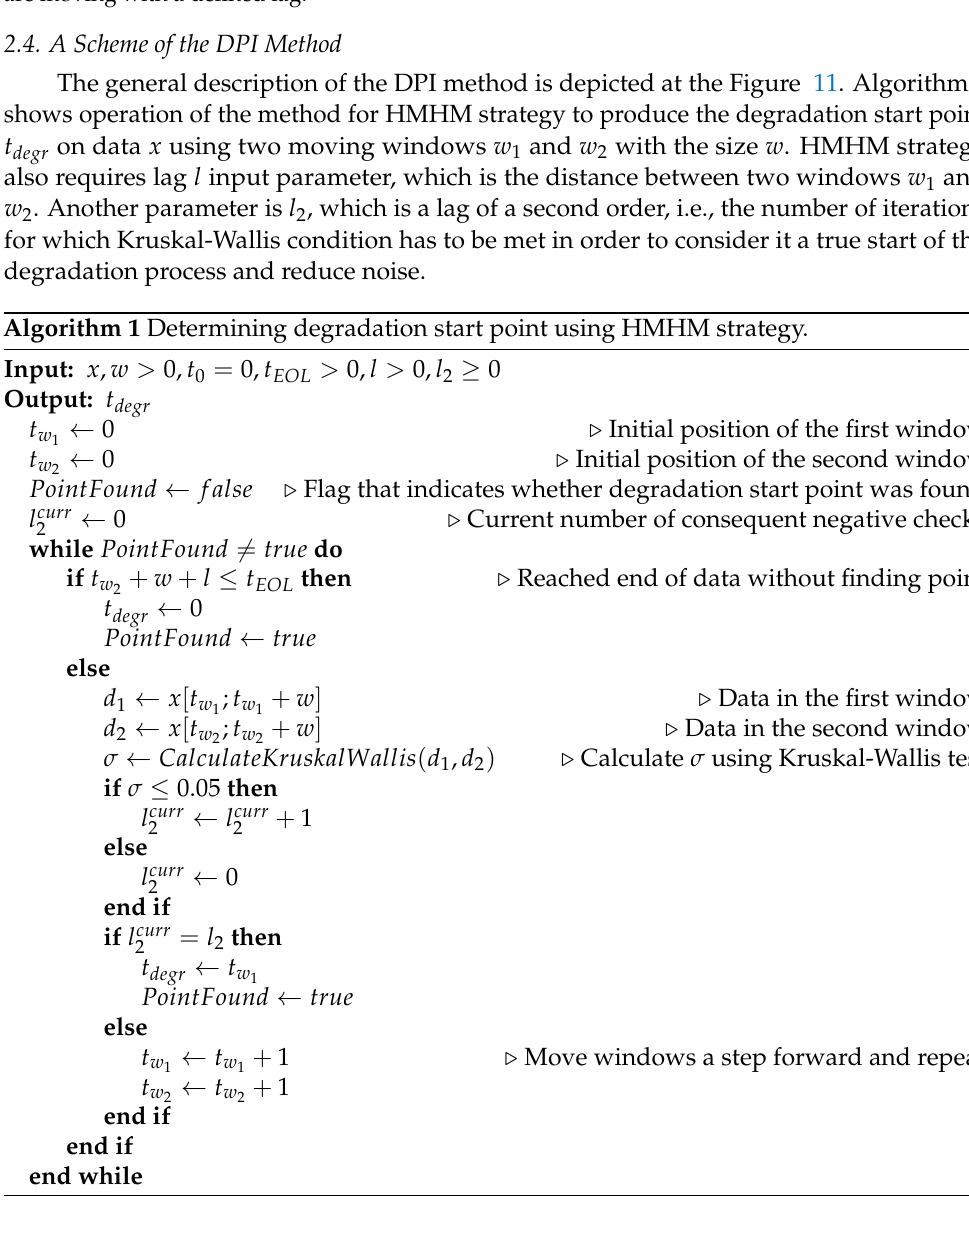
Figure 10. Explanation of HMHM strategy. We see both sliding windows of observation from head are moving with a defined lag.